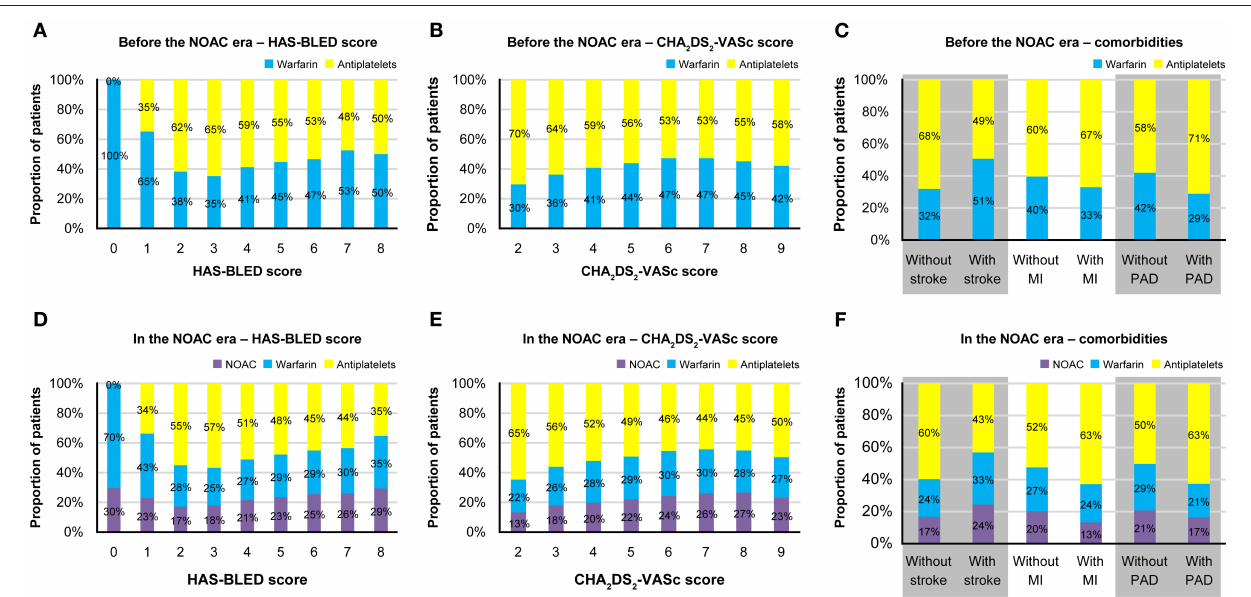
FIGURE 2 | Treatment patterns of antithrombotics before and after the introduction of NOACs. Proportions of patients prescribed each type of antithrombotics before the NOAC introduction (A) according to the HAS-BLED score; (B) according to the CHA 2 DS 2 -VASc score; (C) according to the comorbidities, and after the NOAC introduction (D) according to the HAS-BLED score; (E) according to the CHA 2 DS 2 -VASc score; (F) according to the comorbidities. MI, myocardial infarction; NOAC, non-vitamin K antagonist oral anticoagulants; PAD, peripheral artery